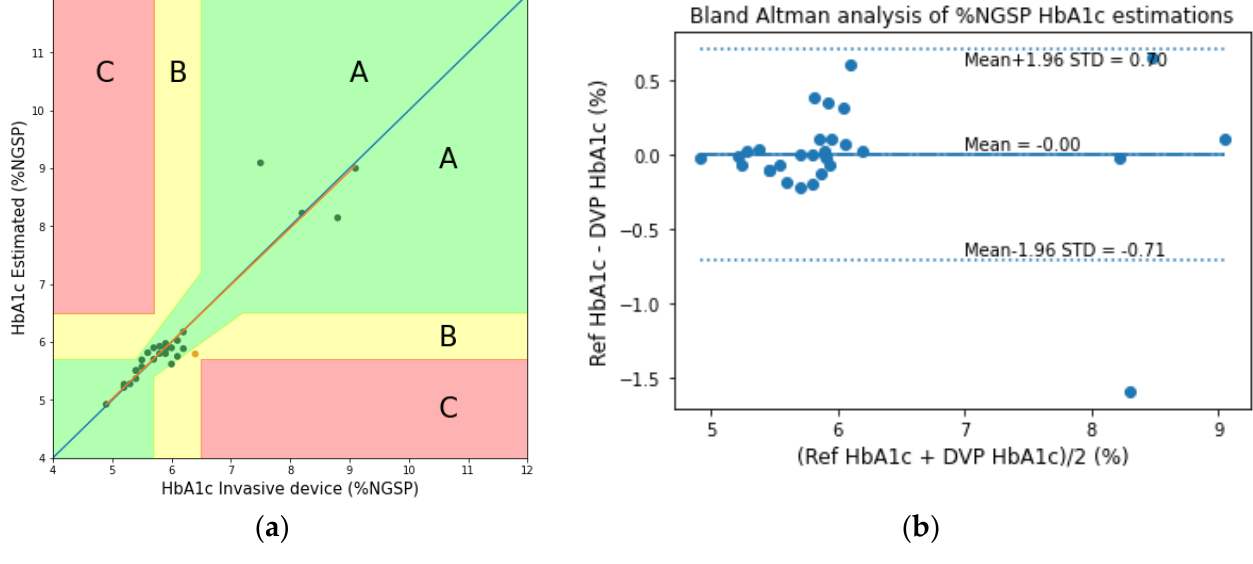
Figure 18. ( a ) Error grid analysis (EGA) and ( b ) the Bland–Altman analysis plots of the experimentally acquired data for the transmission-type signal of the fingertip model.